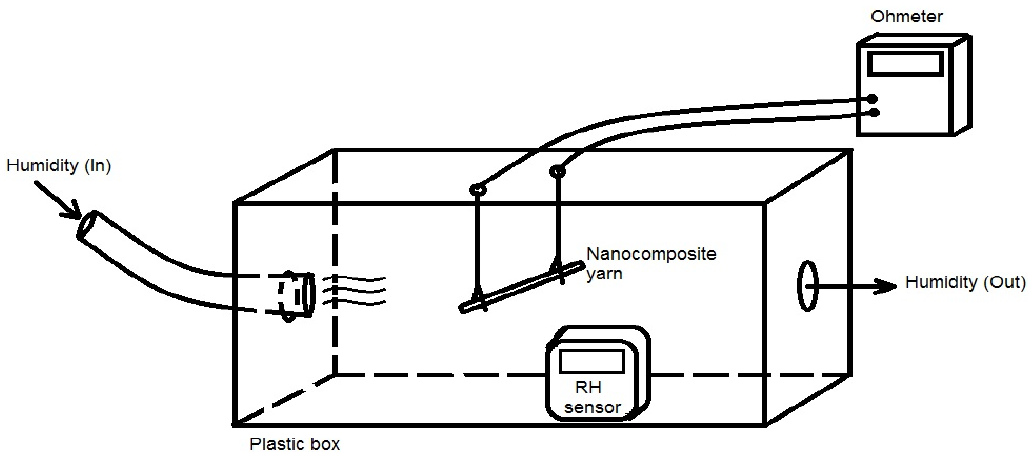
Figure 2. Schematic diagram of the resistance measurement setup, with humidity produced with a commercial humidifier.